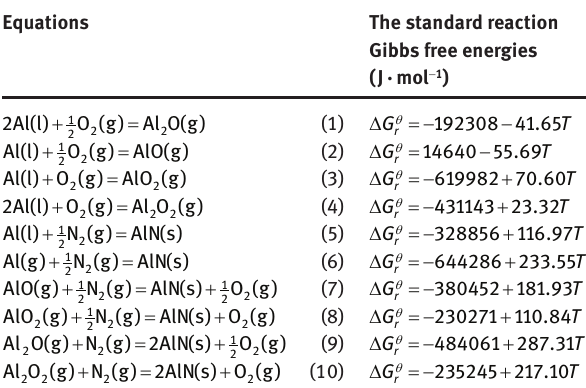
Table 1: The reactions and related thermodynamic data in Al-O-N